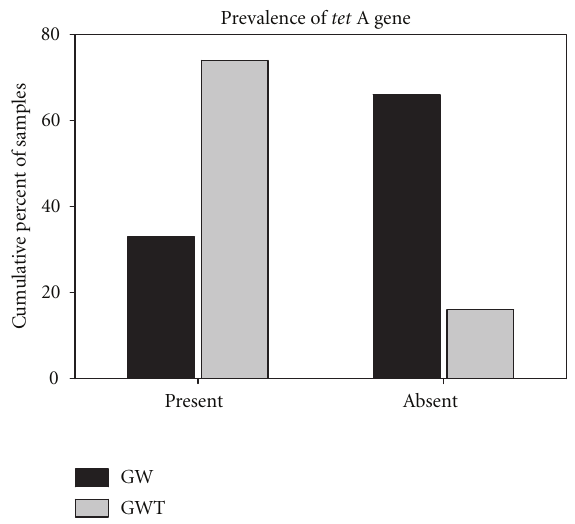
Figure 3: Cumulative prevalence of tet A gene in soils irrigated with greywater and greywater plus